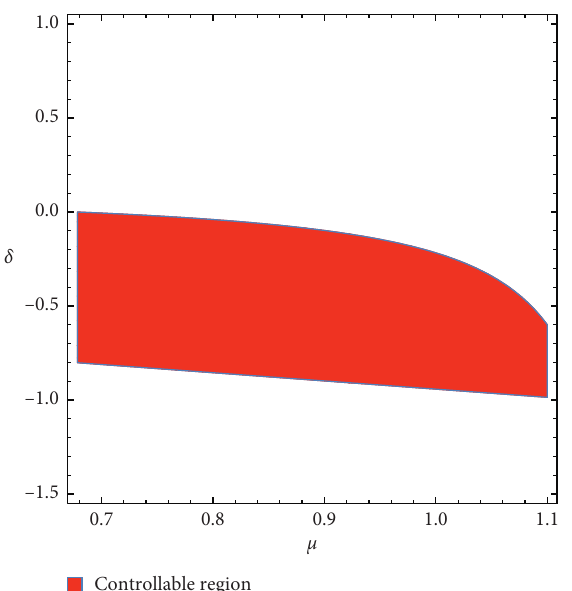
Figure 7: Controllability region of system (64) for a � 41 . 5, b � 85, c � 2 . 7, d � 3 . 4, k � 1 . 4, r � 3 . 5, p � 2 . 3, h � 0 . 75, and μ ∈ [ 0 . 678396 , 1 . 1 ] in μδ